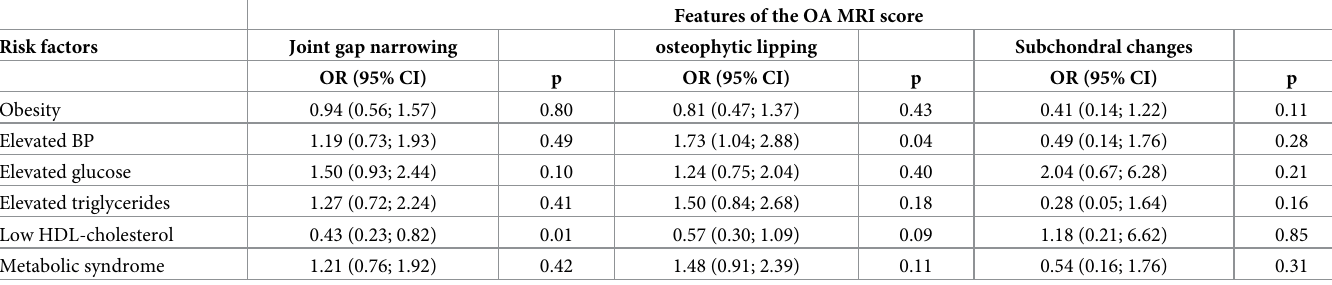
Table 5. Association of metabolic syndrome and its components with features of the OA MRI score for the left